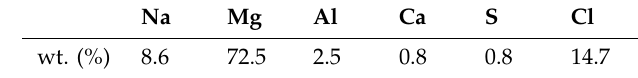
Figure 3. The point of zero charge of BP as a function of initial and equilibrium pH at 25 °C. 3.2. Identification of New Mineral Deposits with Antimony The XRD spectra of the BP and the antimony adsorbed BP were compared to investigate the new mineral deposits through the electrostatic interactions between the BP and antimony (Figure 4). The XRD patterns of the antimony adsorbed BP were similar to those of the BP. However, the antimony adsorbed BP showed a distinctive XRD peak associated with brandholzite at around 20°. These results imply that a brandholzite-like structure was formed through the complexation of magnesium contents of the BP with antimony [10–13]. The brandholzite-like structure of the antimony adsorbed BP was indicative of Mg(H 2 O) 6 and Sb(OH) 6 octahedra units which were interconnected by hydrogen bonding [13]. These octahedra units were arranged in two types of layers loaded along the c-axis [13]. In the mineral structure, one layer consisted of a single Sb(OH) 6 octahedra unit, while the other layer was composed of Mg(H 2 O) 6 and Sb(OH) 6 octahedra units [13]. Our previous research demonstrated that the hydrogen bonding between each octahedral unit by extended X-ray absorption spectroscopy could be mainly attributed to the outer-sphere complex of antimony adsorption by magnesium-rich adsorbents [12]. The remarkable increase in the intensity of the XRD peak related to brandholzite at 20° after the adsorption of antimony (black rhombus) clearly shows that the selective adsorption of antimony using the BP led to the formation of a brandholzite-like structure [12].